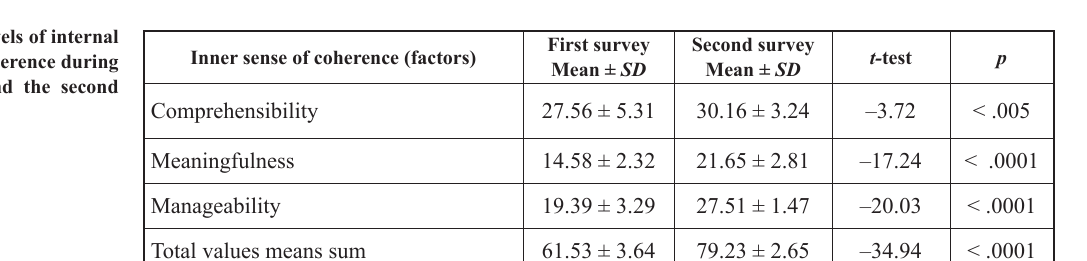
Table 2. Levels of internal sense of coherence during the first and the second survey